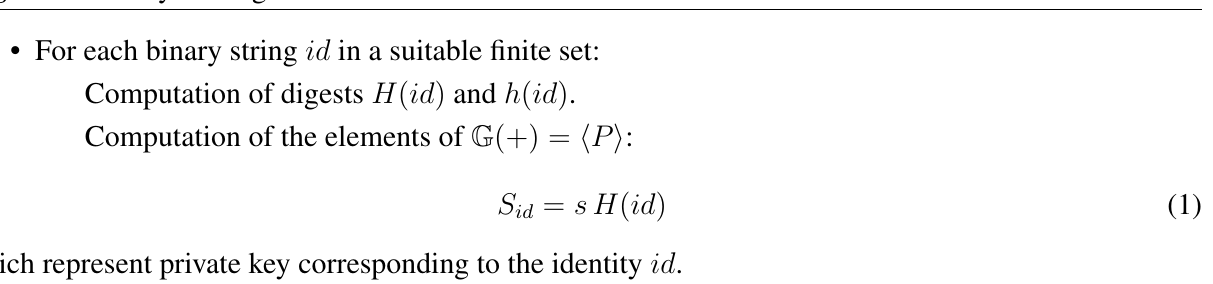
Algorithm 2 KeyGen algorithm